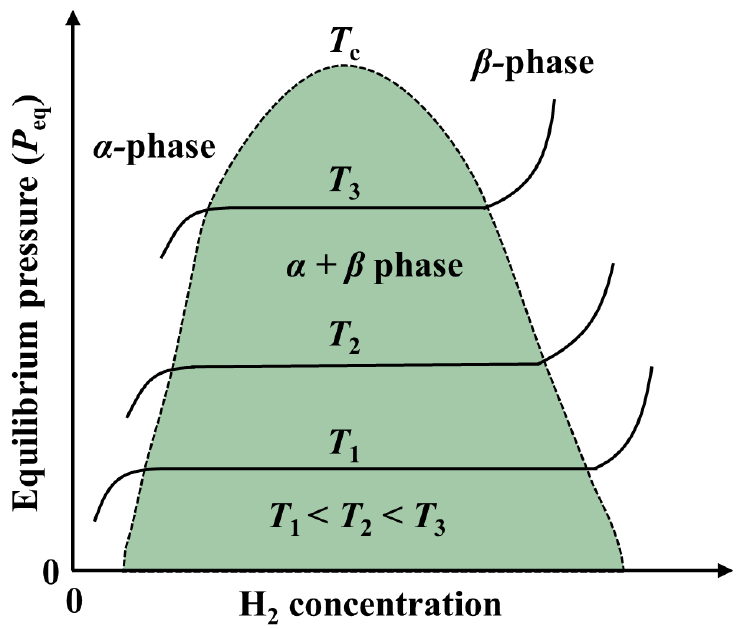
Figure 8. Pressure composition isotherm (PCI) plot of hydrogen-metal systems [85].